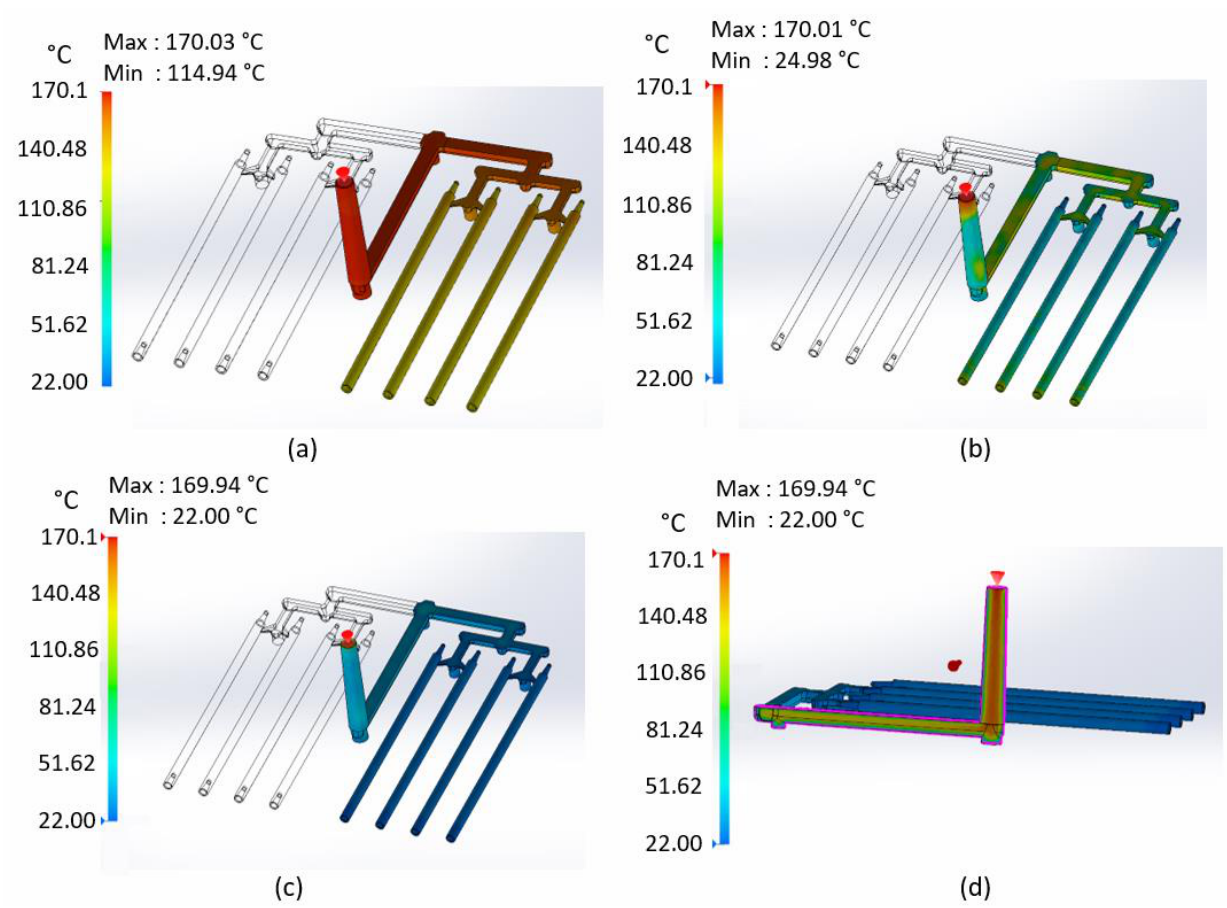
Figure 7. ( a ) Flow front temperature; ( b ) temperature at the end of fill—boundary surface; ( c ) temperature at the end of packing—boundary surface; and ( d ) temperature at the end of packing— clipping section through the runner.